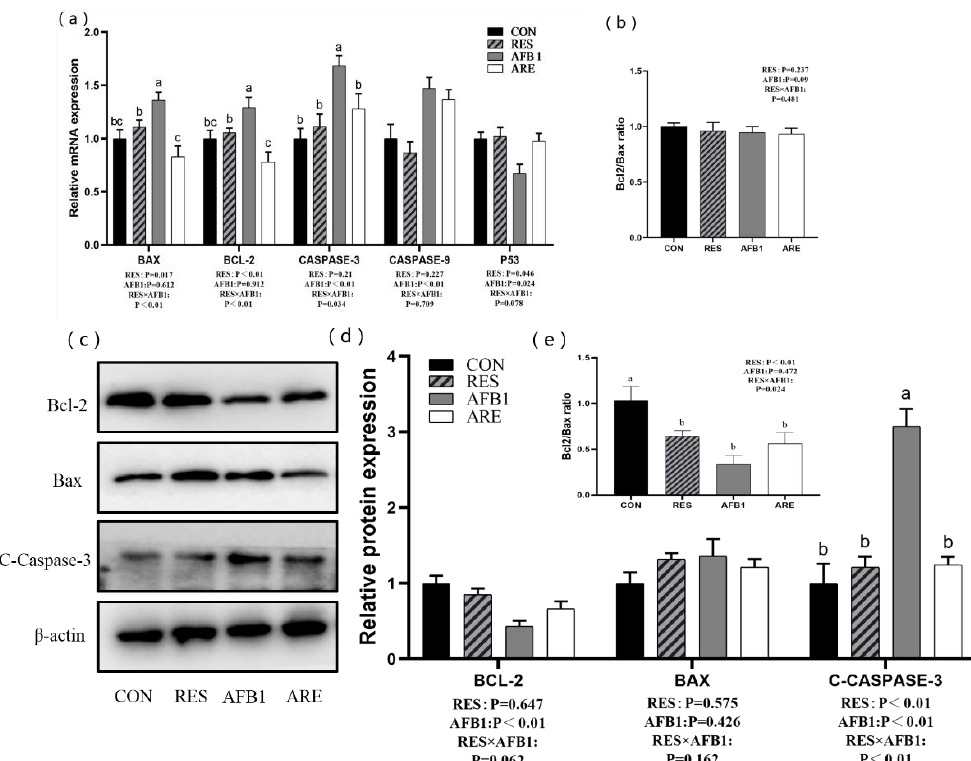
Figure 6. The effect of resveratrol on the hepatic apoptosis in AFB 1 -challenged mice. ( a ) qPCR analysis of hepatic apoptosis mRNA expression in different groups ( n = 6/group). ( b ) Analysis of bcl-2/bax mRNA expression ratio in different groups ( n = 6/group). ( c ) Immunoblot analysis of hepatic apoptosis protein expression in different groups ( n = 3/group). ( d ) Quantification of apoptosis protein expression was performed by measuring gray values using Image-Pro Plus 6.0 software ( n = 3/group). ( e ) Analysis of bcl-2/bax protein expression ratio in different groups ( n = 3/group). All data were analyzed by using two-way ANOVA and Duncan’s post hoc testing, where appropriate. Data are represented as mean ± SEM. a–c Mean values within a line with different superscript letters were significantly different ( p < 0.05). (Bcl-2, 26kDa; Bax, 21kDa; cleaved-Caspase-3, 17kDa; β-actin, 42kDa).